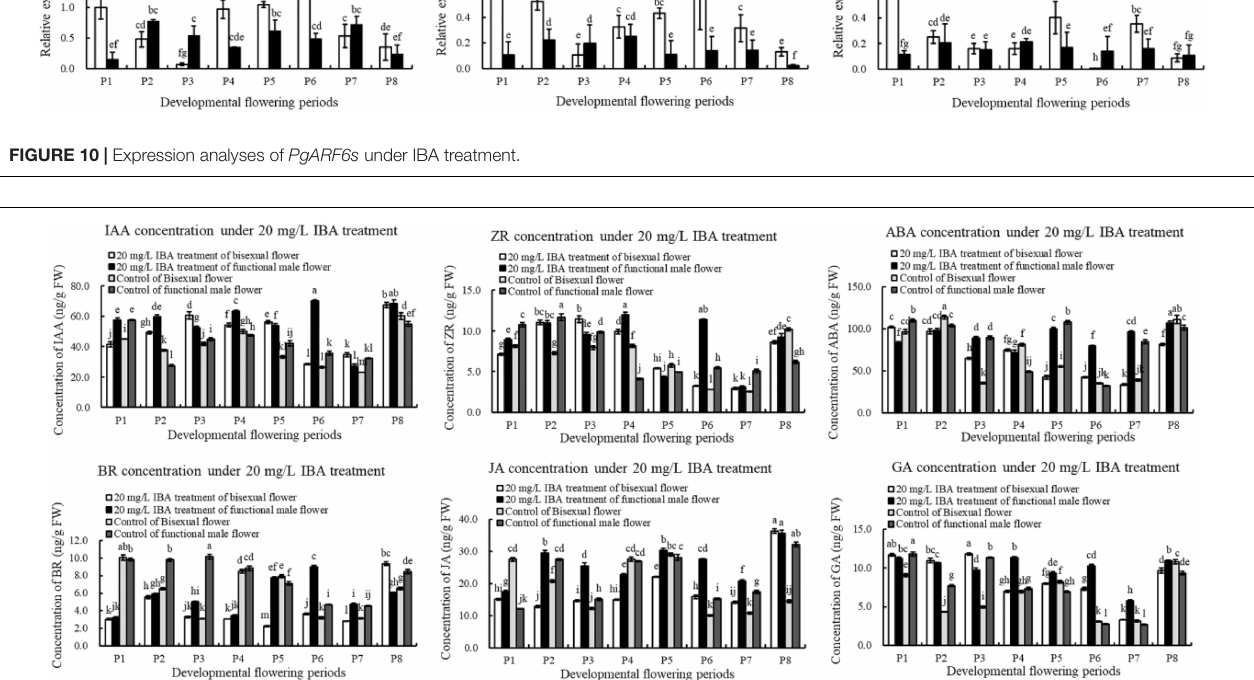
FIGURE 11 | Endogenous hormone in pomegranate flowers under IBA treatment.